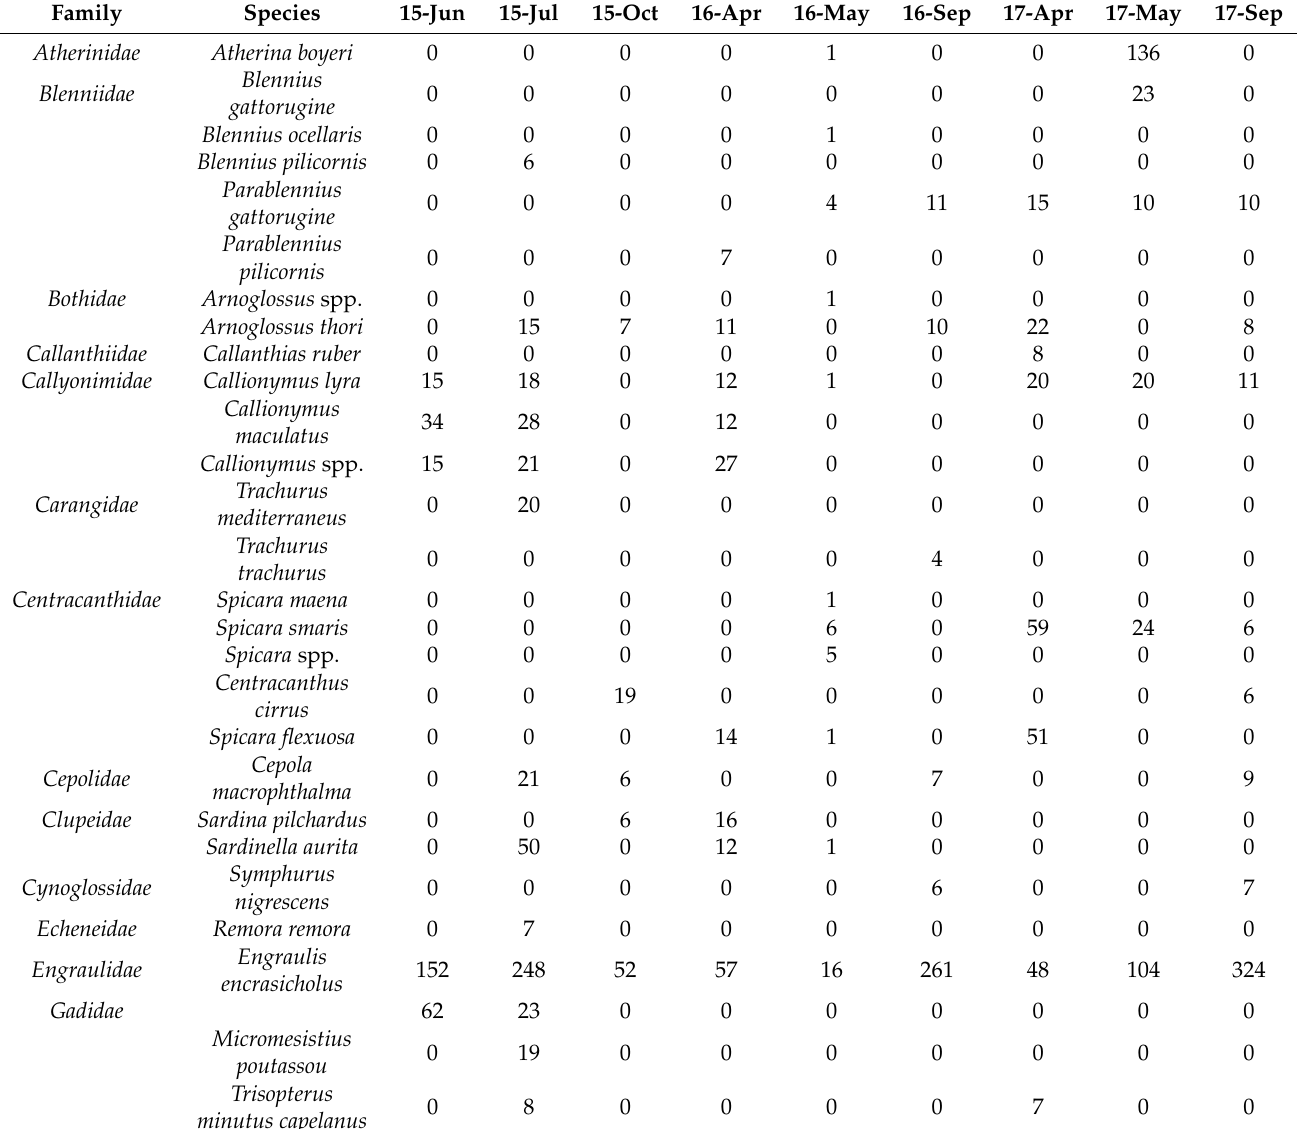
Table 2. List of taxa collected at field sites in the outer region of the Thermaikos Gulf in the Aegean Sea offshore of the coastal zone of Kitros, in the Pieria region of Greece. Numbers show the mean abundance ( N , larvae/10 m 2